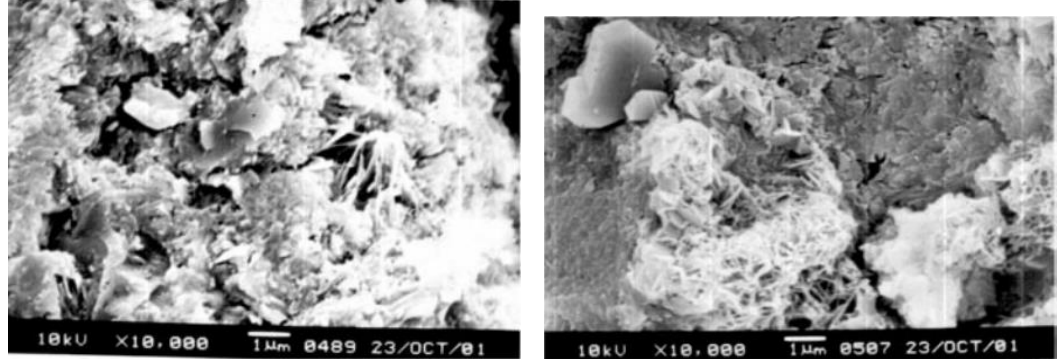
Figure 6: Micro shape and appearance of different test piece